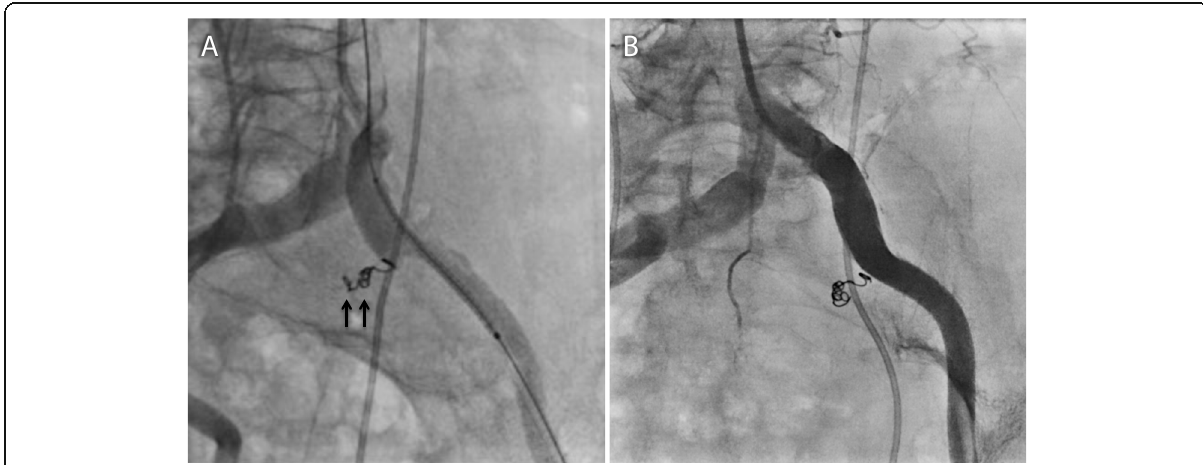
Fig. 3 Implantation of the covered stent and coil embolization. a A Viabahn stent graft of 9.0 × 50 mm was implanted to cover from the crossing of the left ureter and iliac artery to the distal entry of the subintimal lumen ( black arrows denote coils in the left internal iliac artery ). b The final angiography revealed complete closure of the subintimal lumen and the internal iliac